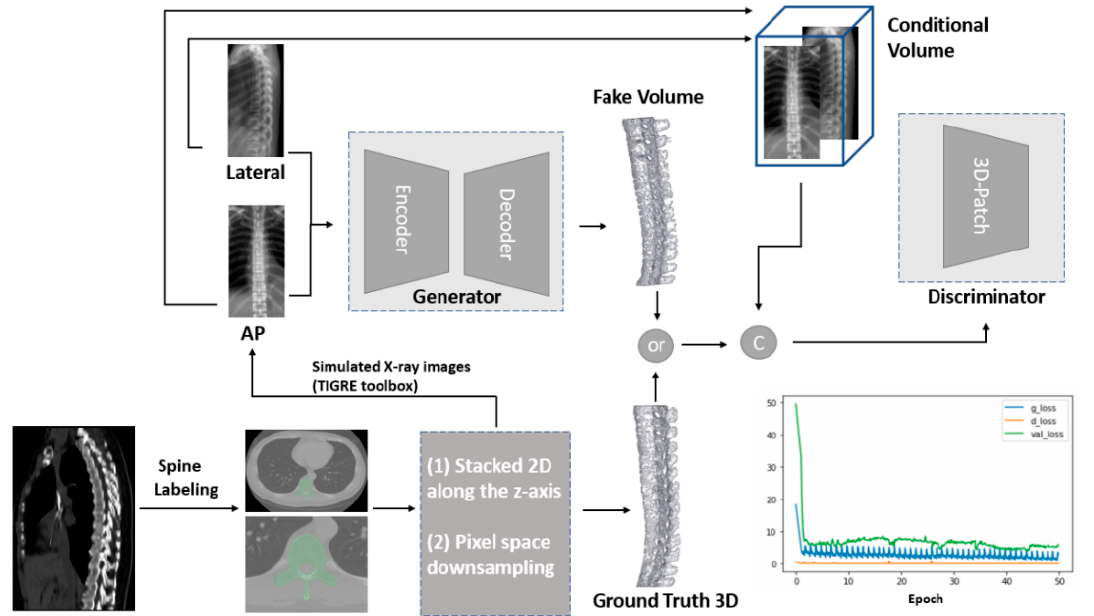
Figure 2. Overview of the whole architecture of the spine 2Dto3D-GAN. Circle C: Concatenate. The GT 3D spine and simulated bi-planar X-ray images were derived from CT via manual segmentation by 3D slicer software and TIGRE toolbox, respectively. The GAN model transformed 2D images into a 3D object.